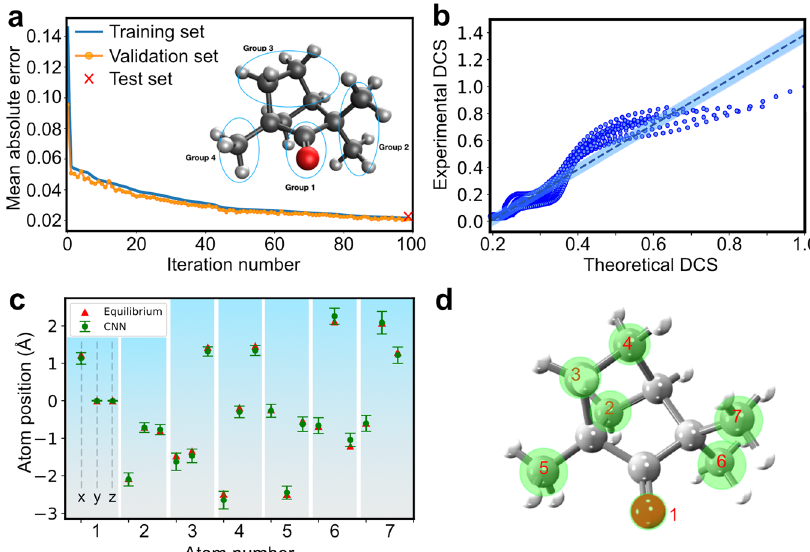
Fig. 4 Extracted ( + )-fenchone molecular structure by machine learning. a Mean absolute error (MAE) at each iteration number using a neural network convoluted with the training and validation sets of simulated data. The MAE obtained with the test data is indicated by the red cross. The inset shows a schematic of the four groups of the ( + )-fenchone molecule which the ML algorithm has been trained on. b Correlation between normalized experimental and theoretical 2D-DCS similar to Fig. 3b. A linear fi t (dashed lined) and the 90% con fi dence interval (blued shaded area) using the bootstrapping method are applied to the correlated scatters. A Pearson correlation coef fi cient of 0.94 is obtained, indicating that a strong correlation between the two data exists. c The predicted ( x, y, z ) 3D positions for seven atoms in ( + )-fenchone using ML model (green circles), where the error bars are derived from the predicted model error plus the experimental statistical error. The equilibrium ground-state 3D positions of neutral ( + )-fenchone are shown (red triangles). d Schematic of the predicted 3D molecular structure. The green circles indicate the area of